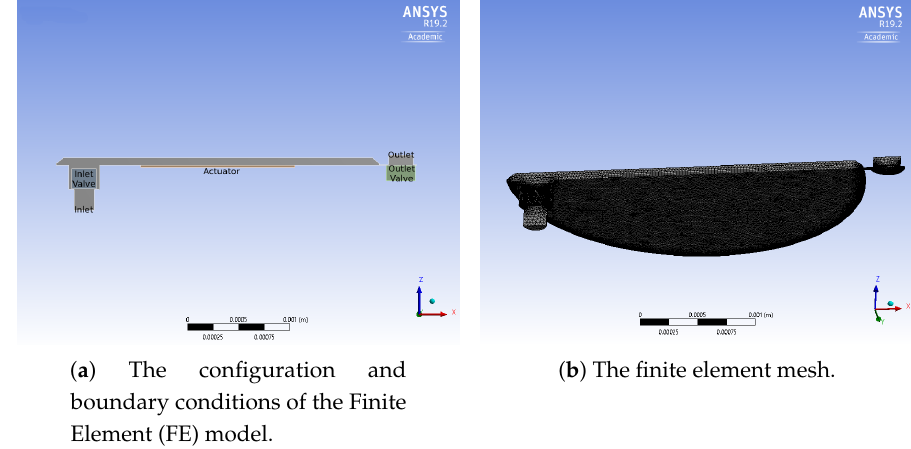
Figure 16. The FE model built to simulate the micropump